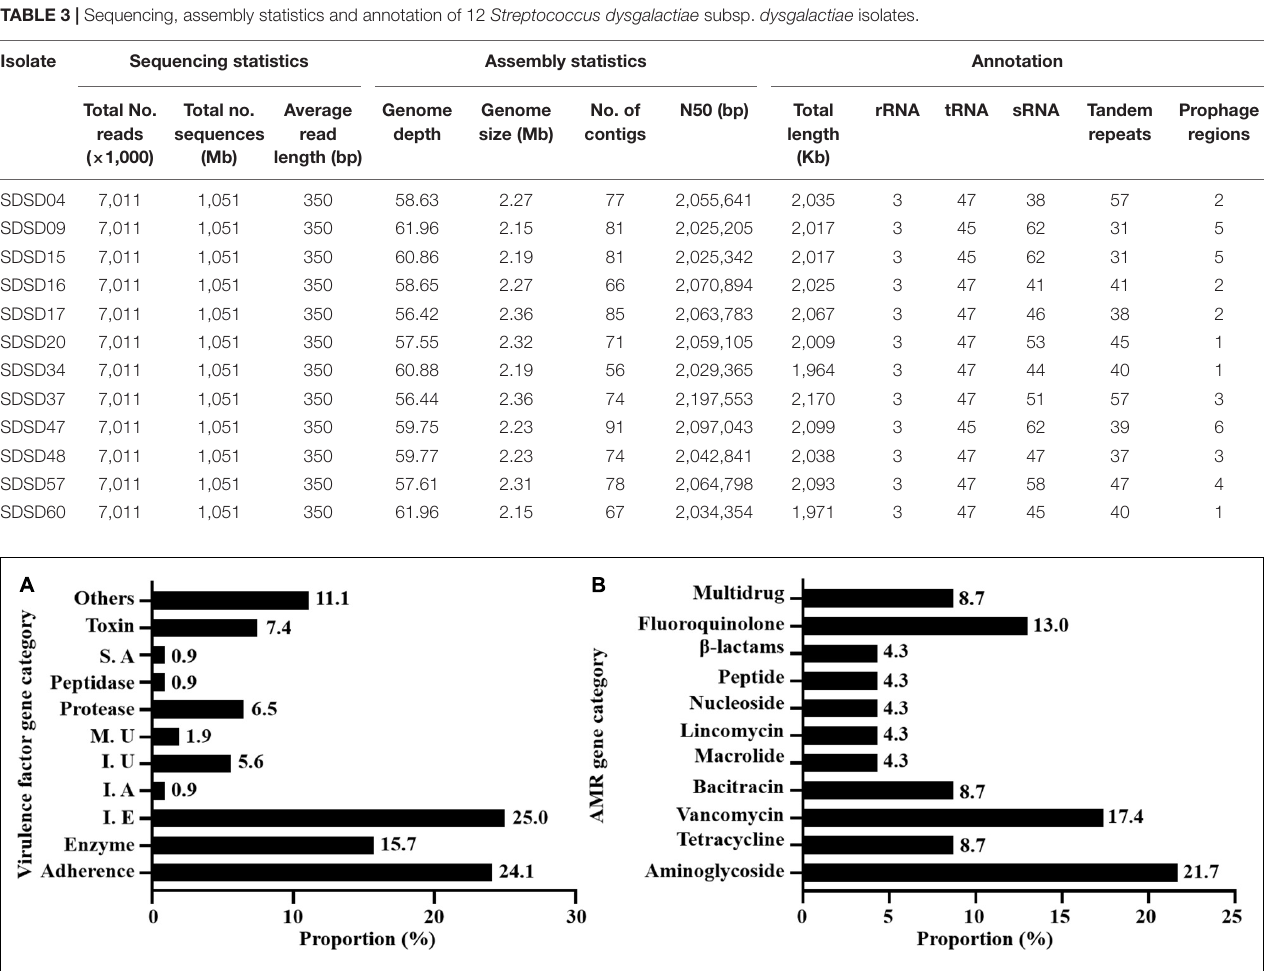
FIGURE 3 | Occurrence of virulence (A) and AMR (B) genes of 12 SDSD strains isolated from bovine milk samples with clinical and subclinical mastitis in 7 provinces of China. (A) There were 11 main virulence categories: adherence, enzyme, immune evasion (I. E), immune reactive antigen (I. A), iron uptake (I. U), manganese uptake (M. U), protease, peptidase, superantigen (S. A), toxin, and others. (B) There were 10 AMR categories: aminoglycoside, tetracycline, vancomycin, bacitracin, macrolide, lincomycin, nucleoside, peptide antibiotics, β -lactams, fluoroquinolone, and